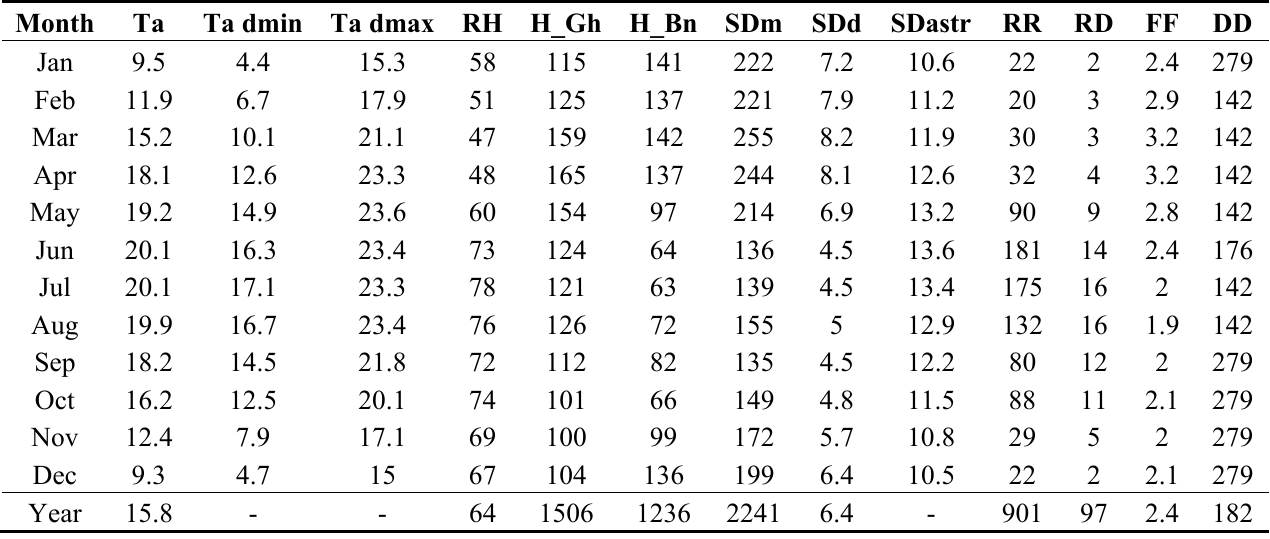
Table 3. Table of Kunming (25 °N) Climate Data Summary (MeteonormV6.1 data period: 1996–2005).